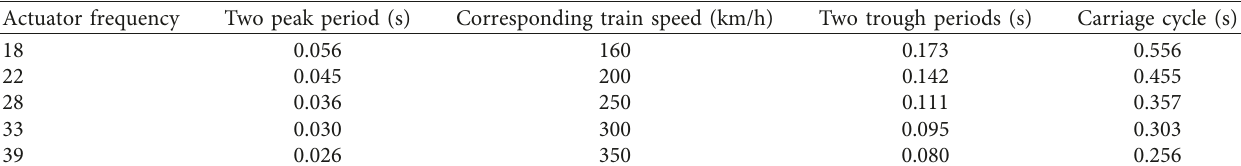
Table 2: Train speed and